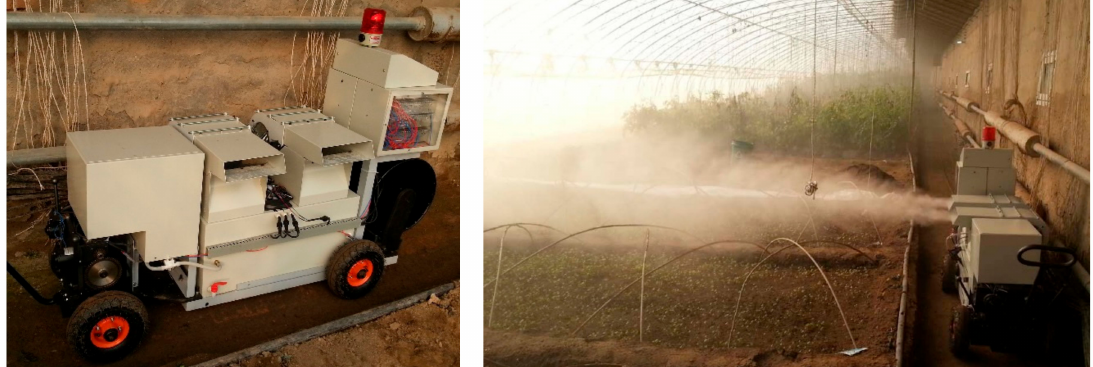
Figure 1. The self-propelled high-energy ultrasonic atomizer used in the